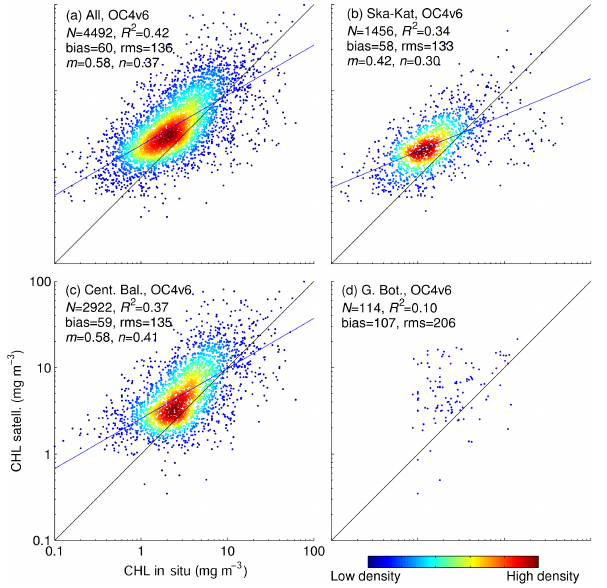
Figure 3. Density scatter plots of in situ vs. satellite-retrieved Chl a for the OC4v6 algorithm. The best linear regression (blue) and the line of equal value (black) are superimposed, with relevant statistics.